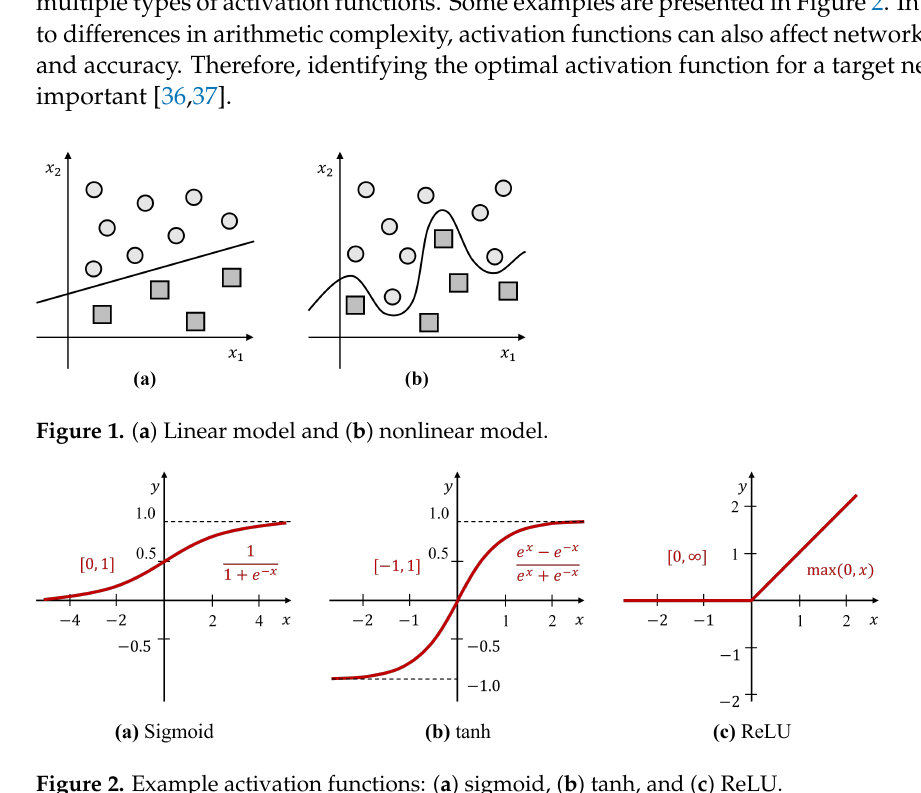
Figure 2. Example activation functions: ( a ) sigmoid, ( b ) tanh, and ( c )